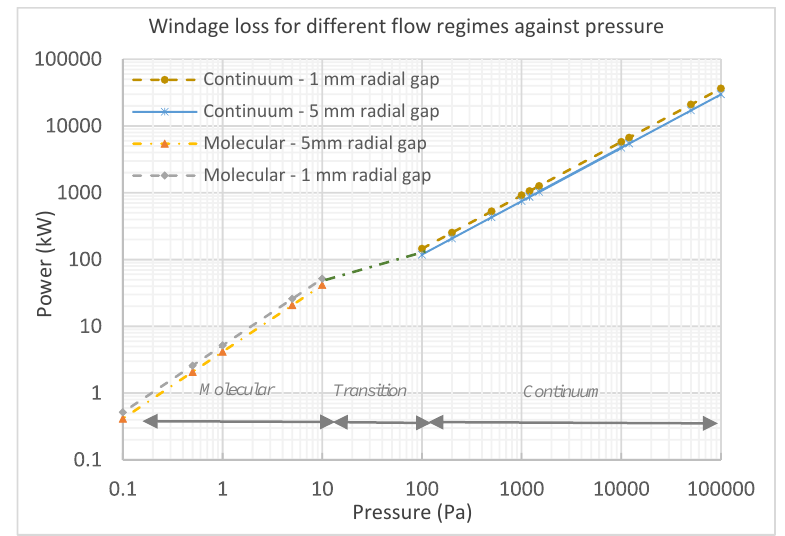
Figure 8. Windage loss against pressure for continuum and molecular flow regimes.